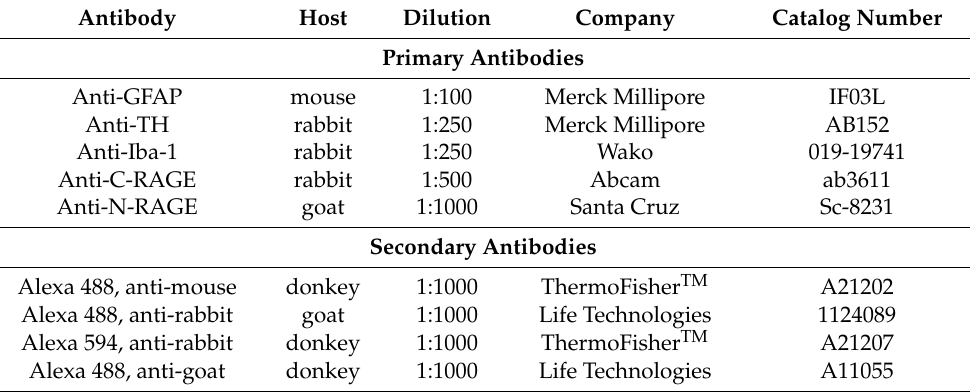
Table A1. Primary and secondary antibodies used for western blot and